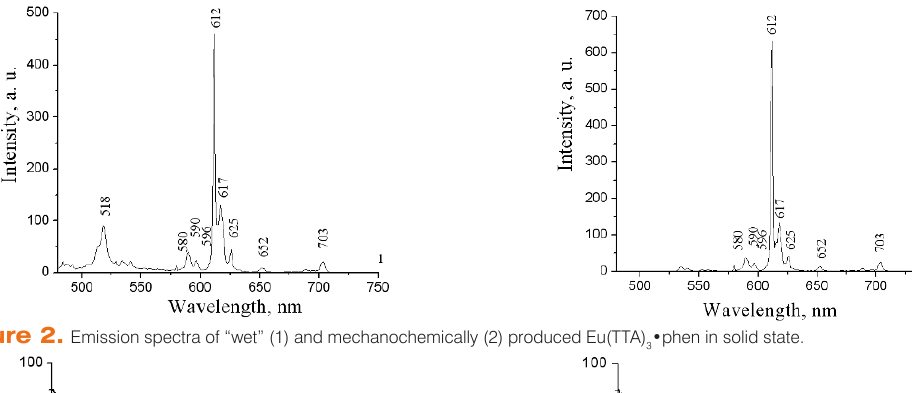
(1) and mechanoactivated EuCl mixture